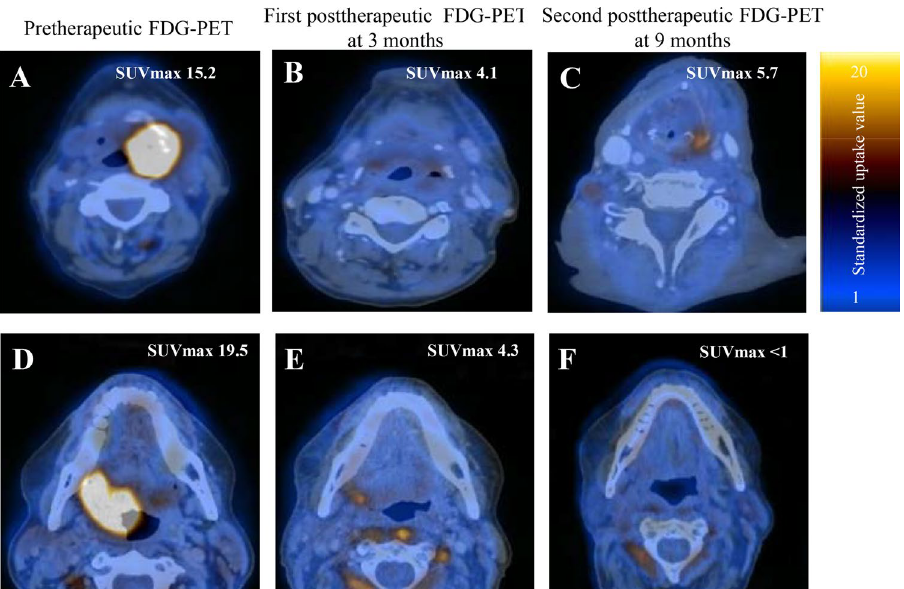
Figure 4. Representative axial fused FDG-PET/CT images demonstrating SUV max changes in patients with head and neck carcinoma. The first patient had hypopharyngeal carcinoma and received chemoradiation. After initial decrease of SUV max between the pretherapeutic scan ( A ) and the first post-therapeutic FDG- PET (3 months) ( B ), there was an increase in SUV max in the second post-therapeutic FDG-PET (9 months) ( C ). Local recurrence was confirmed by histopathology following the 9 months FDG-PET. Other example of oropharyngeal cancer patient. SUV max decreased between the pretherapeutic ( G ), first FDG-PET after 3 months ( H ) to a similar level as shown in the first patient (Panel A and B). In the second post-therapeutic FDG-PET, however, SUV max of primary tumor area further decreased. Patient is free of disease upon last